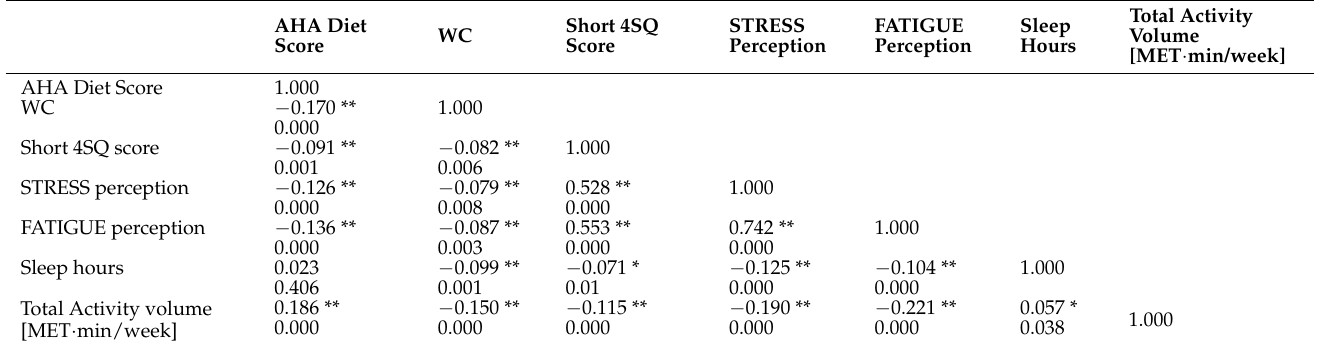
Table 3 report a simple correlation matrix between self-reported measures of nutrition, WC, somatic symptoms, stress and fatigue perception, sleep, and total volume of physical activity. Note the significant correlations between data, with the exception of sleep hours and AHA score. Table 3. Spearman’s Correlation within selected